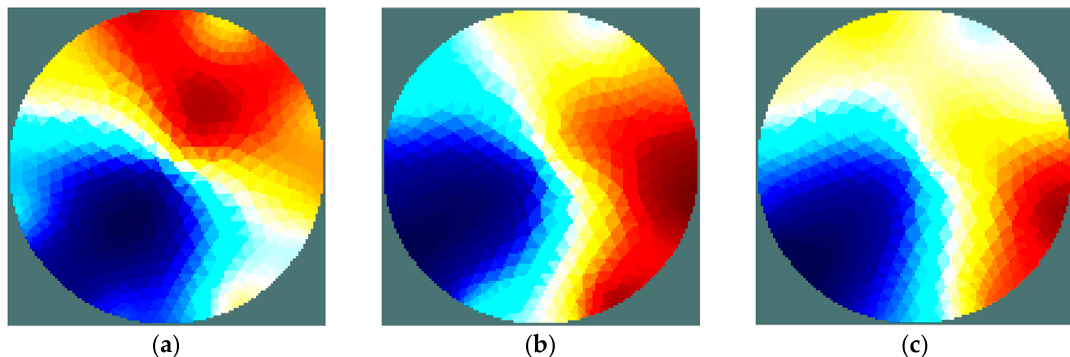
Figure 13. Case 2: Chokeberry with water content of 69.0% / 54.2%. Reconstructed images for voltage stimulation of 100 Hz ( a ), 1 kHz ( b ), 10 kHz ( c ).